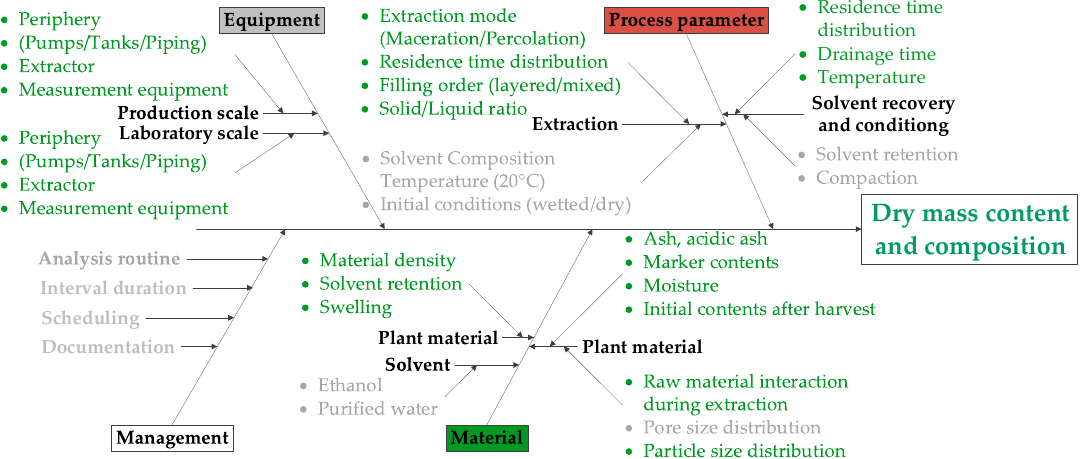
Figure 5. Ishikawa diagram for the considered solid-liquid extraction process.